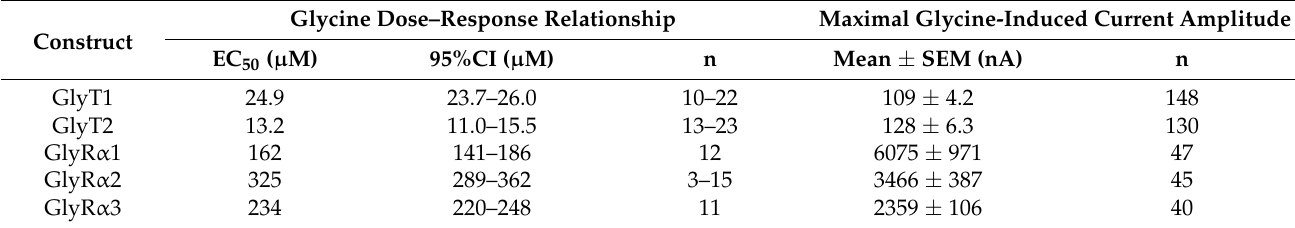
Table 2. Electrophysiological data of glycine